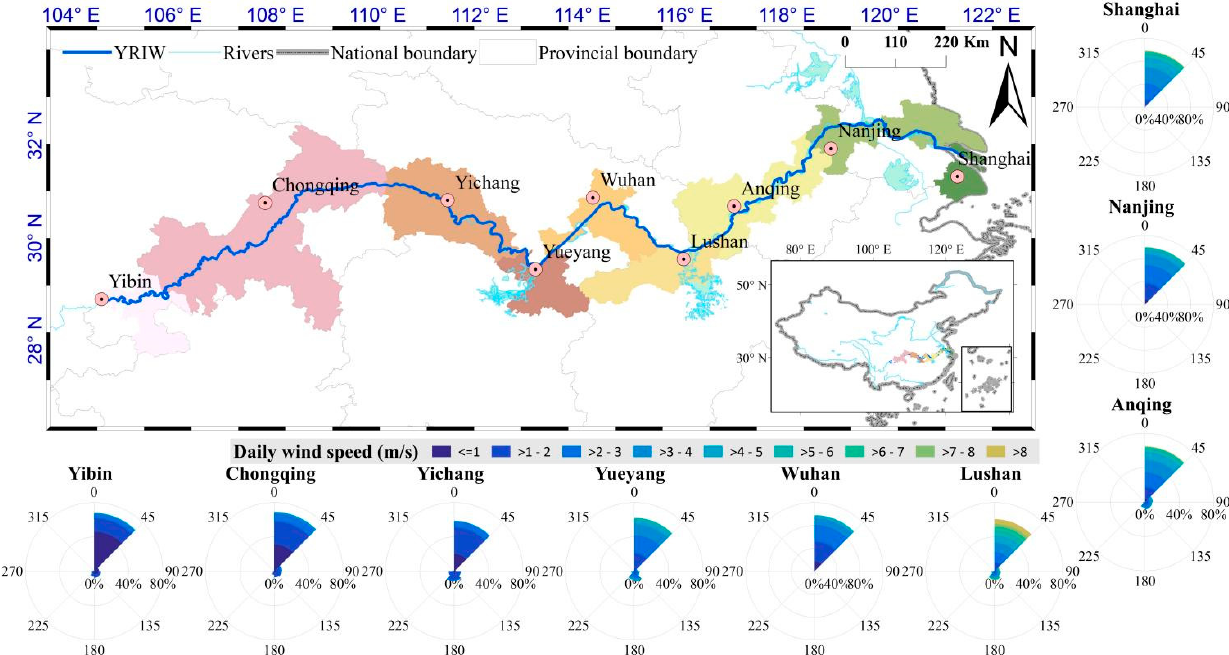
Figure 1. Location and wind–rose of the weather observing stations in the Yangtze River inland ports.